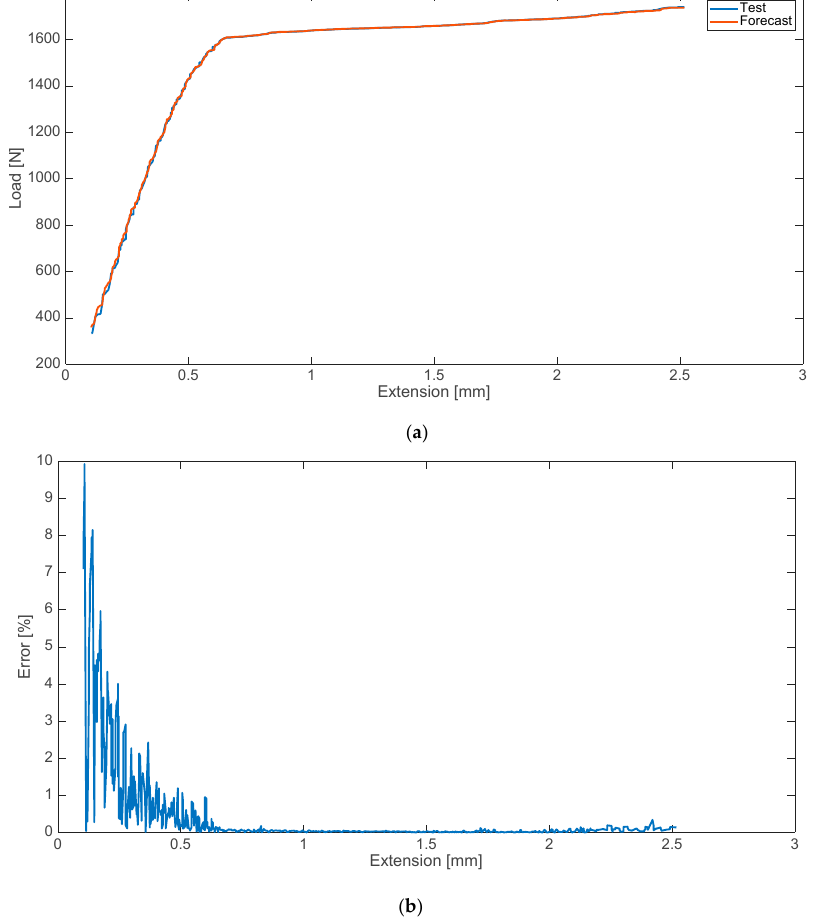
Figure 5. Strength characteristics ( a ) and error values ( b ) for 8% saline admixture.